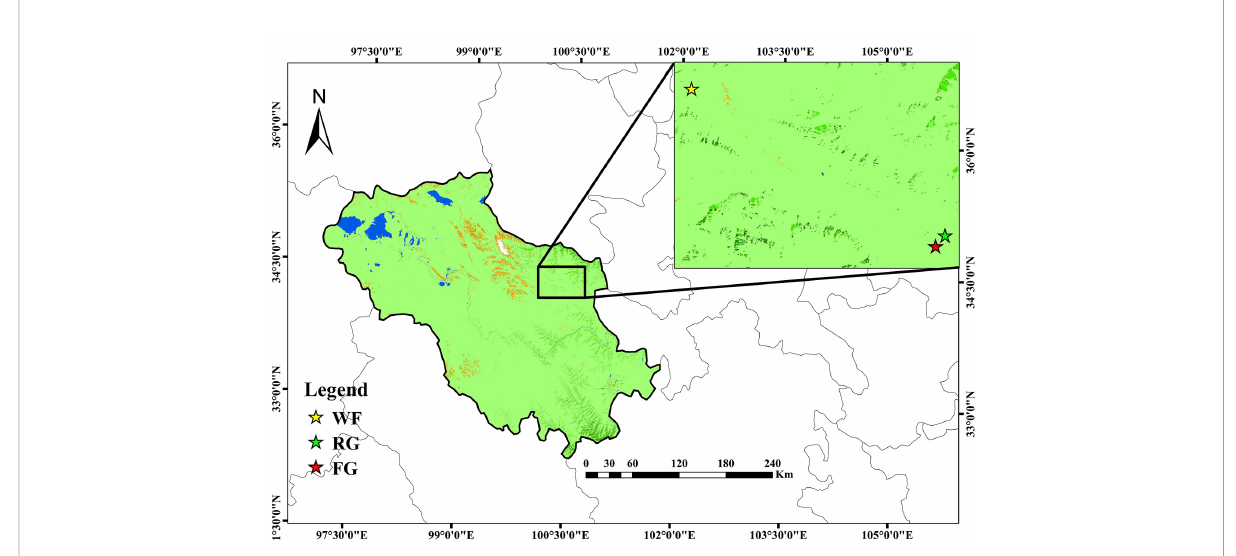
FIGURE 1 Locations of the sampling sites in Maqin County. FG, free grazing; WF, enclosure; RG, arti fi cial grass